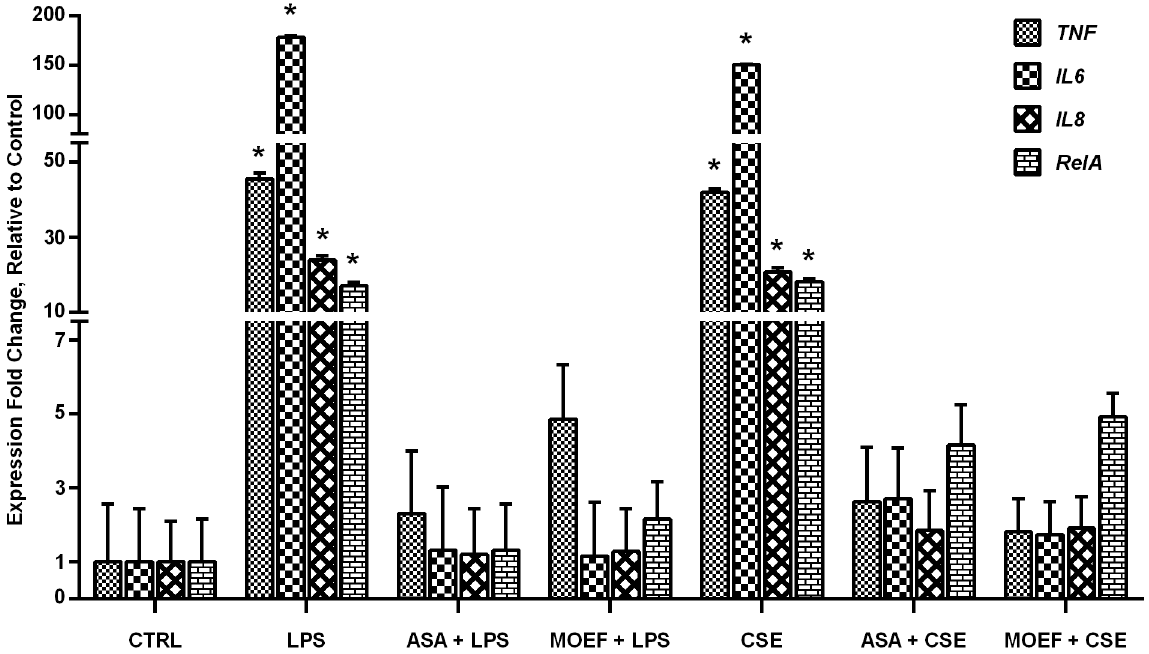
Figure 4. Effects of MOEF on LPS- and CSE-induced TNF , IL-6 , IL-8 and RelA gene expression in human MDM. Cells were pre-treated with MOEF, ASA or diluent for 6 h and then stimulated with LPS or CSE. After a further 12 h incubation culture supernatants were harvested to quantify the cytokines mRNA by one-step qRT-PCR. Results are presented as Mean ± SEM of normalized data of three experiments each conducted with cell from different individual and each in triplicate. Statistical analyses; * p < 0.01 by ANOVA, compared to non stimulated